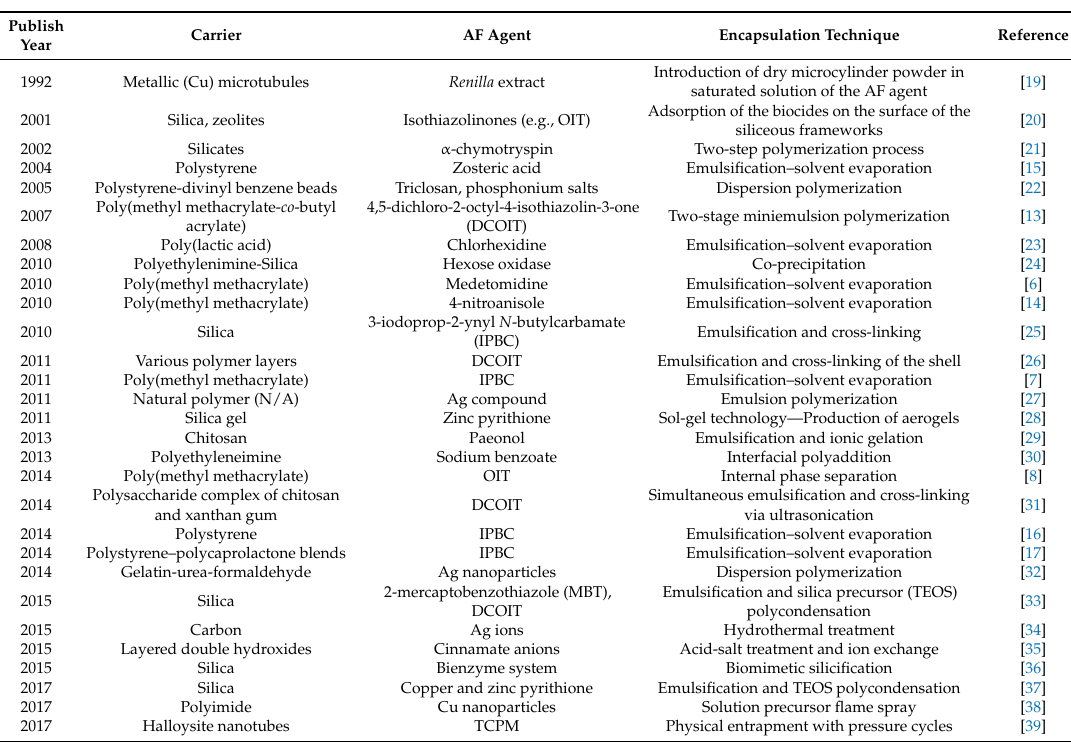
Table 1. Previous encapsulation studies on antifouling (AF)